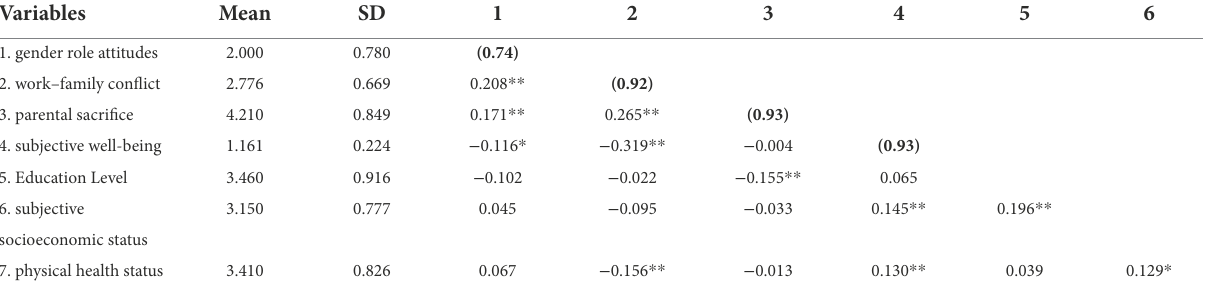
TABLE 1 Descriptions, inter-correlations, and reliabilities of the study variables.